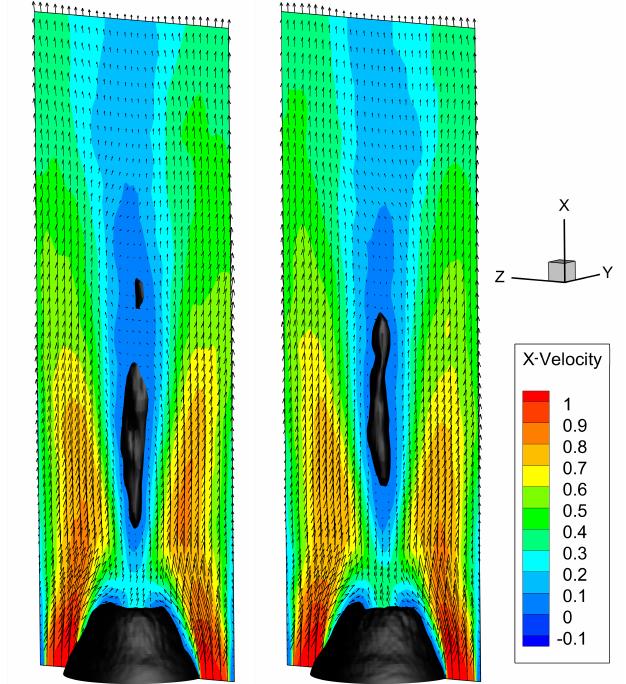
Figure 10. Reconstruction of the axial velocity fields ( m / s ) by 2D ROM using the second mode pair ( St = 0.0729), with a black isosurface of zero axial velocity and the velocity vectors shown. Left : Reconstruction with the minimal temporal coefficient. Right : Reconstruction with the maximal temporal